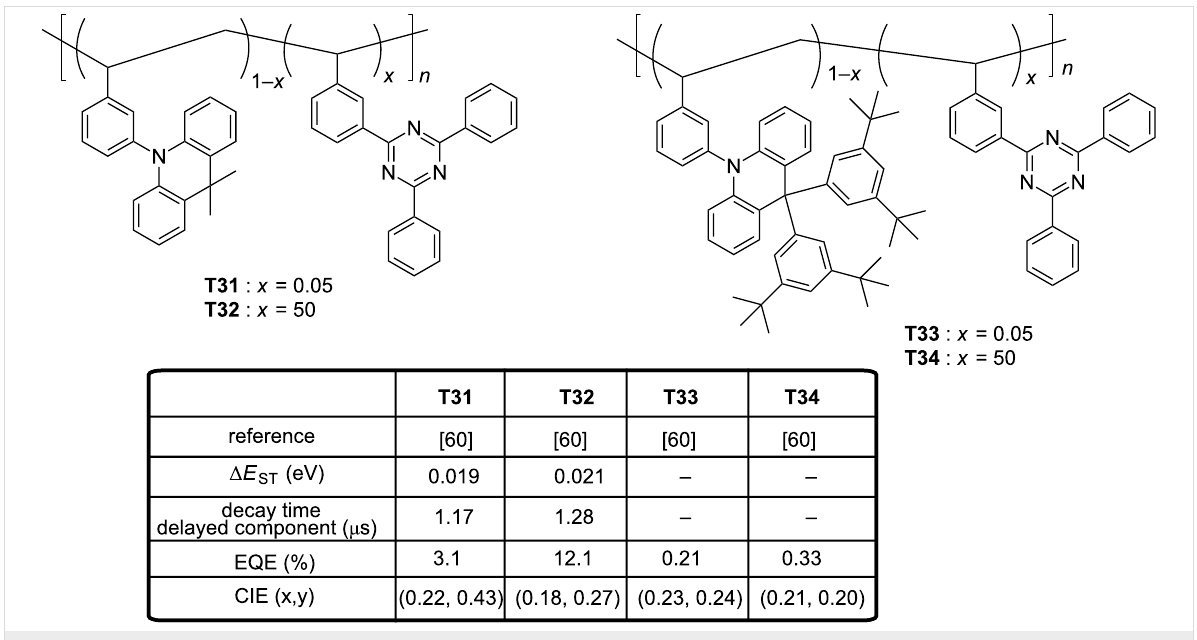
Figure 9: Triazine-based TADF polymers T31 – T32